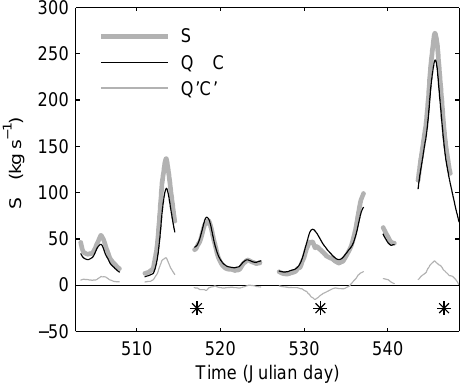
Fig. 10. Decomposition of suspended sediment load into tidal mean and intra-daily contributions, showing the latter to be